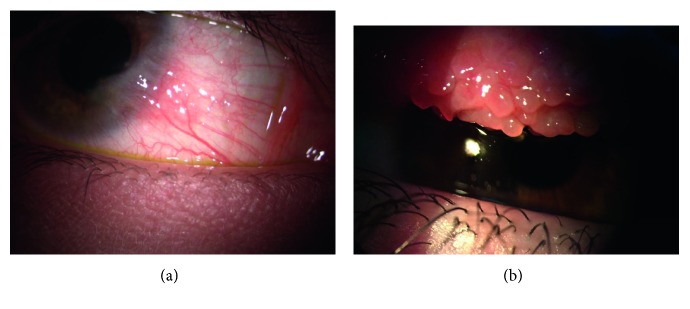
Patient affected from vernal keratoconjunctivitis (VKC). (a) Mixed form with cornel signs limbar neovascular and (b) tarsal papillae on the superior conjunctiva.